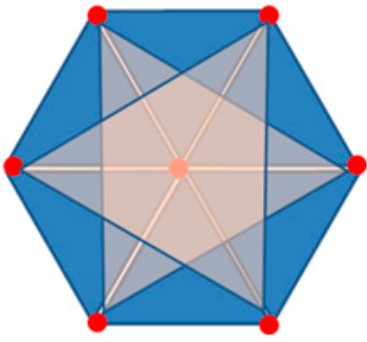
Figure 4. Selecting the Target Points for Trilateration.